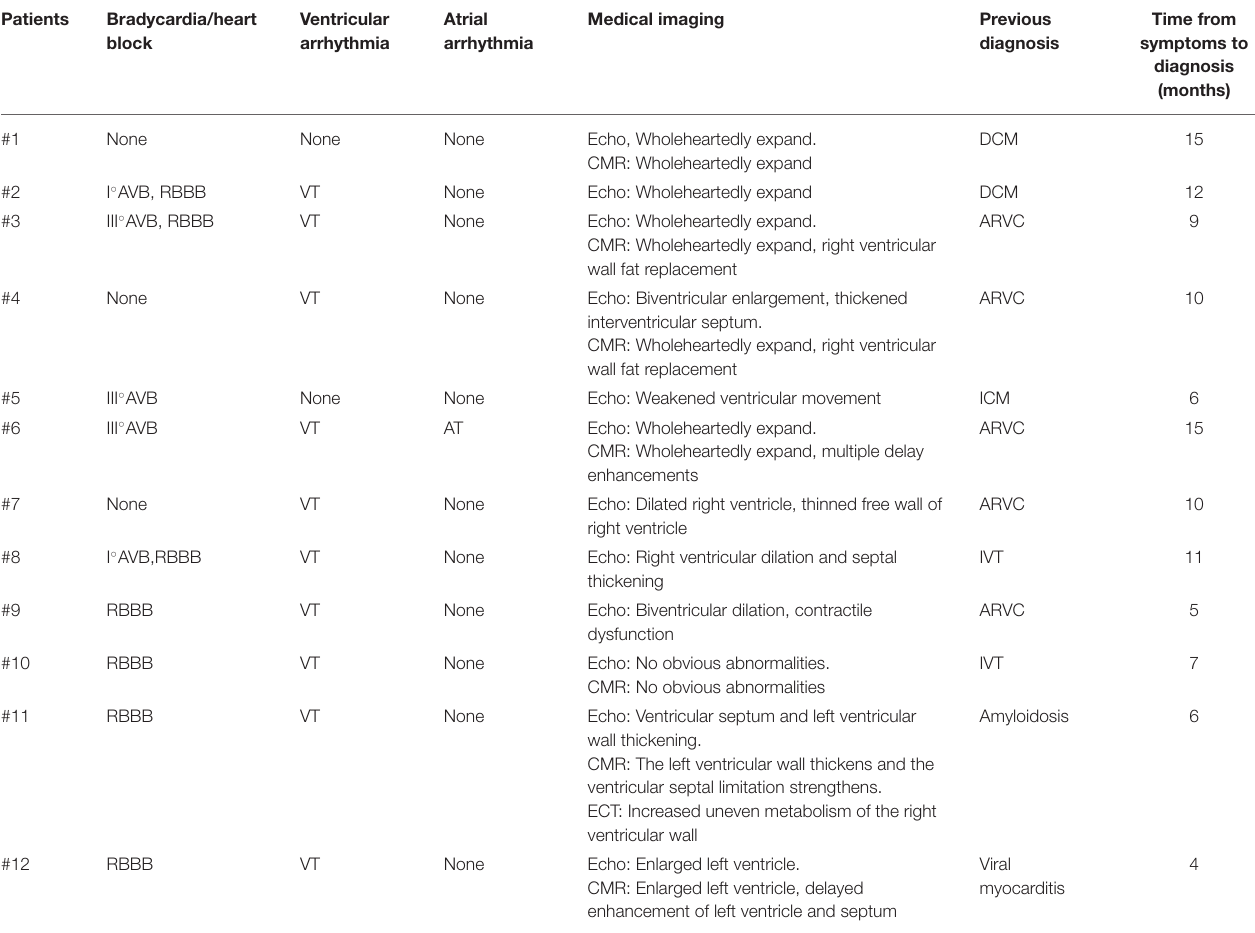
AVB, Atrioventricular block; RBBB, Right bundle branch block; VT, Ventricular tachycardia; AT, Atrial tachycardia; Echo, Echocardiography; CMR, Cardiac magnetic resonance; ECT, Emission computed tomography; DCM, dilated cardiomyopathy; ARVC, arrhythmogenic right ventricular cardiomyopathy; ICM, ischemic cardiomyopathy; IVT, Idiopathic ventricular